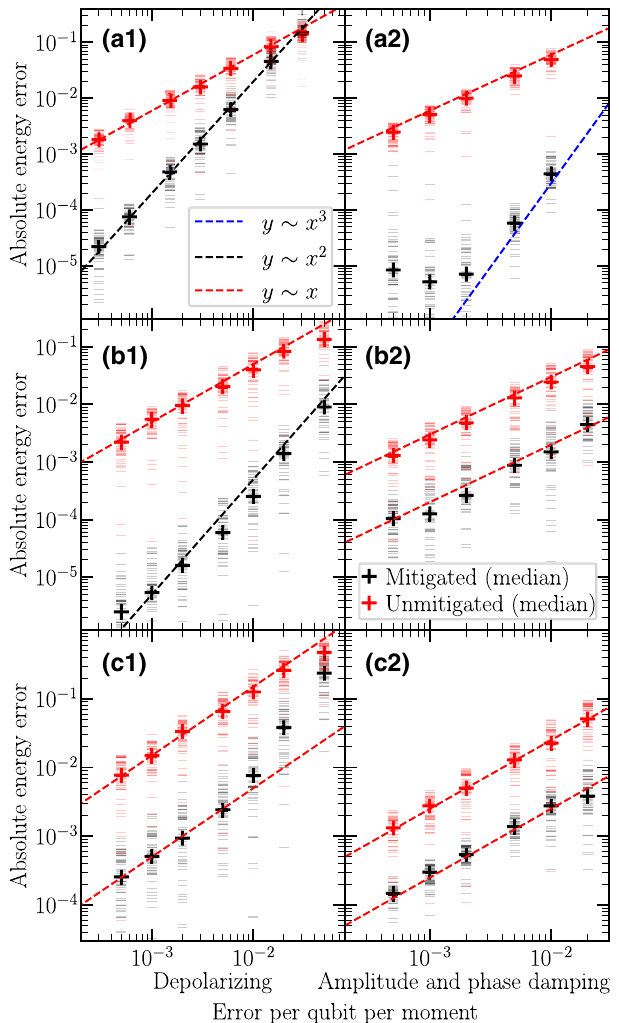
FIG. 6. Mitigation of a four-qubit fermionic swap network via verified phase estimation. Three different VPE protocols are explored—a low-rank factorization (top row), a control-free number-conserving Pauli decomposition (middle row), and a single-control Pauli decomposition (bottom row). Details of all decompositions are given in the text. The low-rank factoriza- tion is studied for the H 2 Hamiltonian at the equilibrium bond distance with a swap network of depth 4, while the other two models are studied at a bond distance of 2 Å with a swap net- work of depth 6. All protocols are tested under depolarizing (left column) and amplitude and phase damping (right column) noise models. In all plots, the median error (crosses) is calculated over 50 different estimations for each error rate using either stan- dard partial state tomography (red) or using verified control-free phase estimation. Individual data points (dashes) are addition- ally shown. For reference, dashed lines showing linear (red), quadratic (black), and cubic (blue) dependence on the gate error rate are